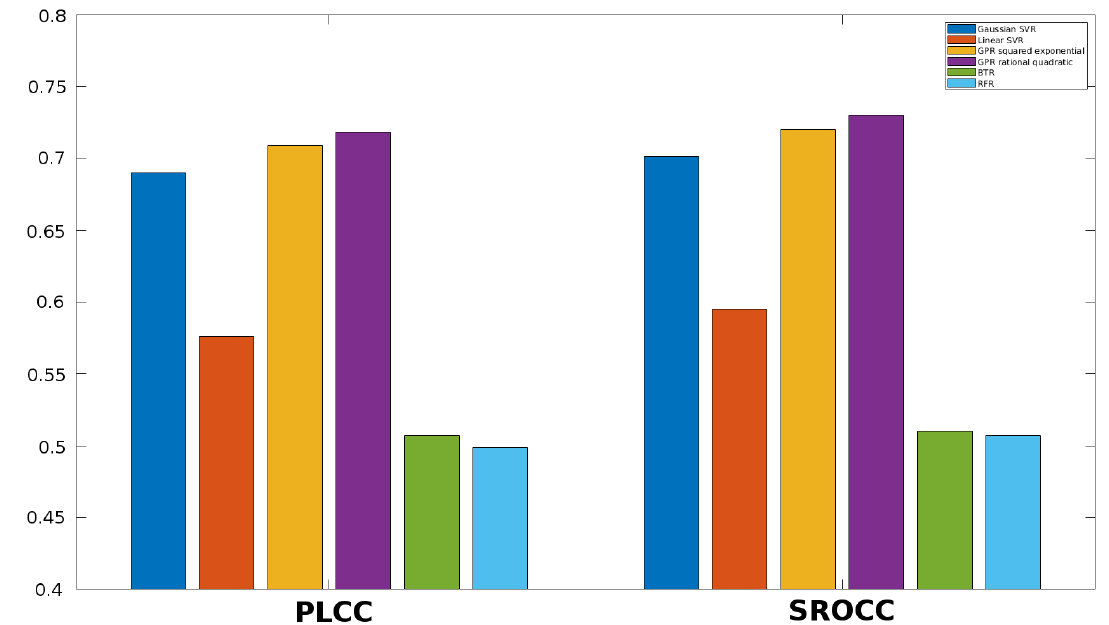
Figure 6. Comparison of different regression methods (SVR with Gaussian kernel function, SVR with linear kernel function, GPR with squared exponential kernel function, GPR with rational quadratic kernel function, BTR, and RFR). Mean PLCC and SROCC values were measured over 20 random train-test splits on ESPL-LIVE HDR